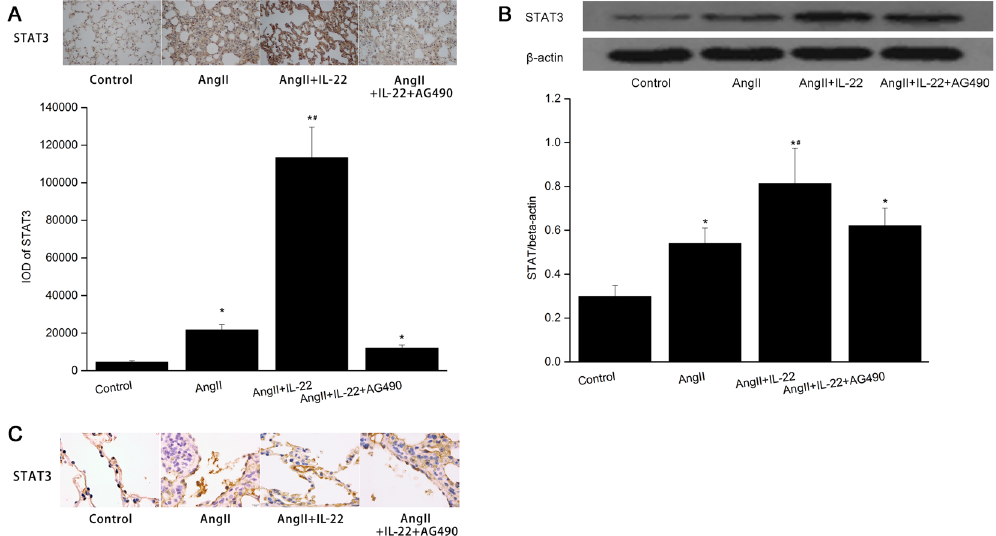
Figure 4. IL22 contributed to the expression of STAT3 in the lung tissues in mice. Immunohistochemistry ( A , B ) indicated IL22 induced up-regulation of STAT3 in the lung tissues, but such fact was inhibited after AG490. The raw data were listed in the Supplementary file. ( C ) Western blot analysis indicated the expression of STAT3 in the lung tissues in the AngII + IL22 group was higher than the other groups. * P < 0.05 versus control group; # P < 0.05 versus AngII group and AngII + IL-22 + AG490 group. The images of immunohistochemistry were observed under a magnification of 400 × and 1000 × , respectively.